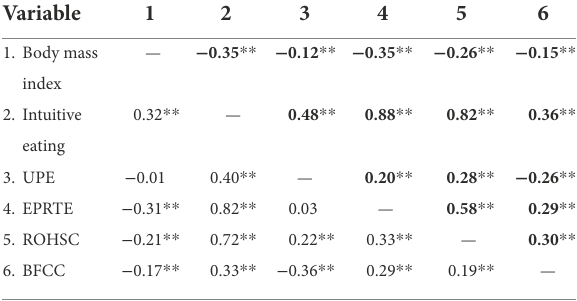
TABLE 1 Sample characteristics. TABLE 2 Intercorrelations for study